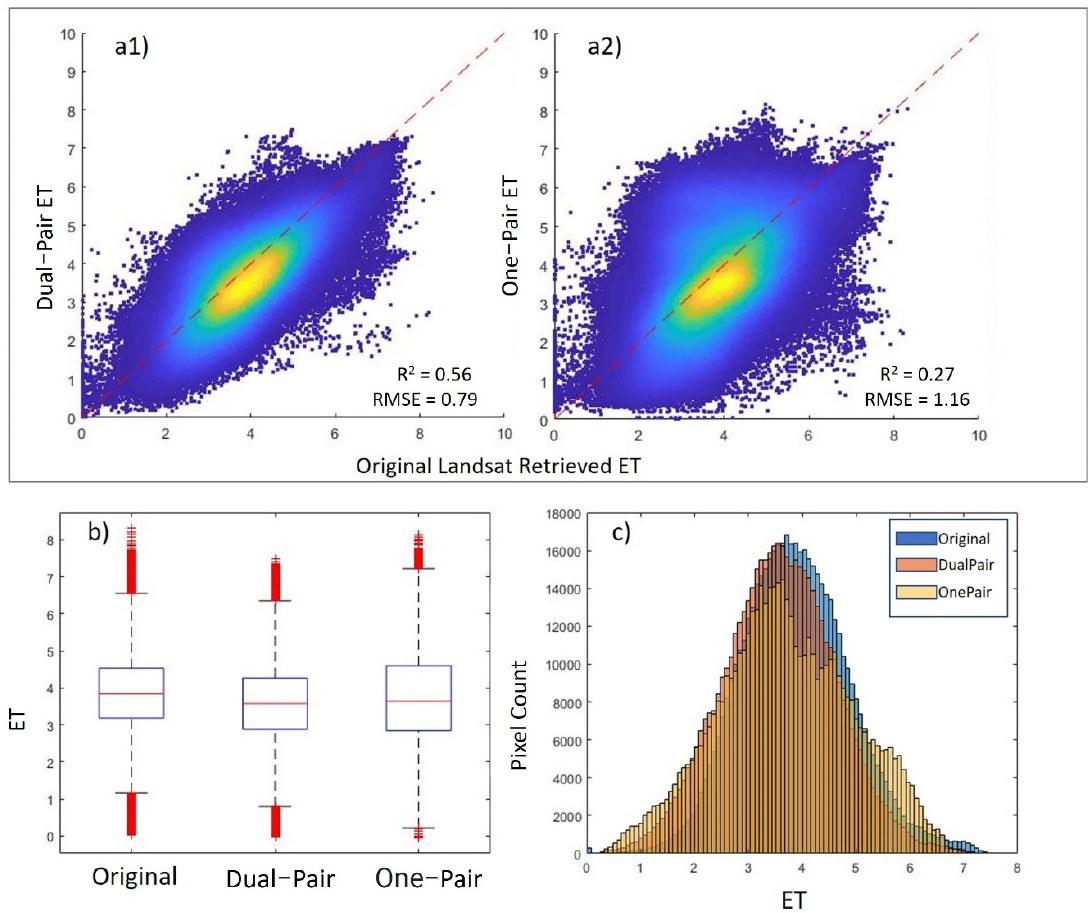
Figure 8. Performance of one-pair and dual-pair STARFM method over vineyards in the study area for DOY2014173. a1) The scatter plot of original Landsat ET and reproduced Landsat ET using dual-pair method. a2) The scatter plot of original Landsat ET and reproduced Landsat ET using the one-pair method. b) The box plot of original Landsat ET, reproduced ET using the dual-pair and one-pair methods. c) The histogram of original Landsat ET, reproduced ET using the dual-pair and one-pair methods.